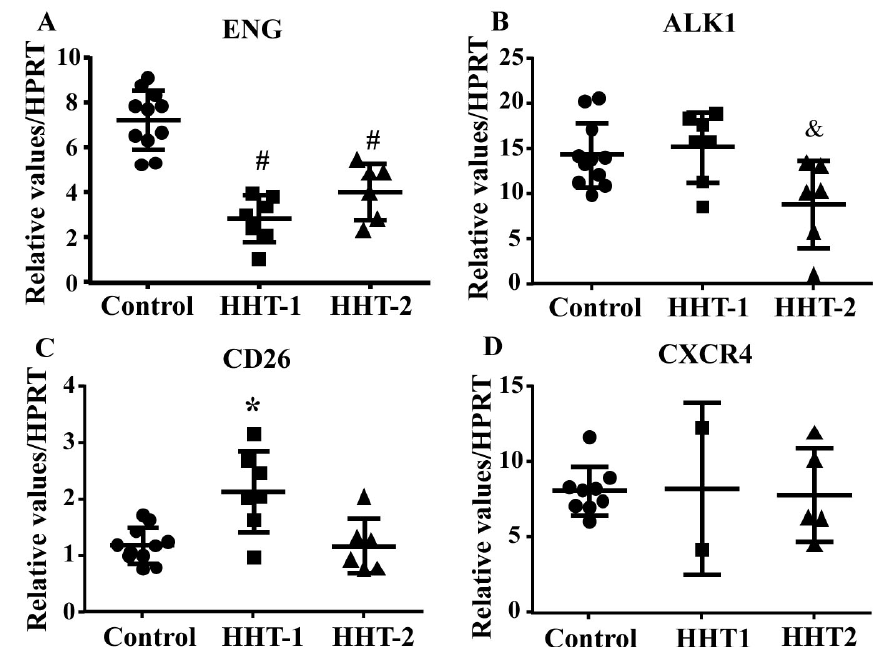
Figure 4. CD26 expression is increased in HHT1 MNCs. A. Quantification of ENG mRNA. #: P < 0.001 compared to control; #: P < 0.001 compared to control. B. Quantification of ALK1 mRNA. &: P = 0.03 compared to control. C. Quantification of CD26 mRNA. *: P = 0.002 compared to control. D. Quantification of CXCR4 mRNA. For A, B and C, N = 11 for control, N = 7 for HHT1 and N